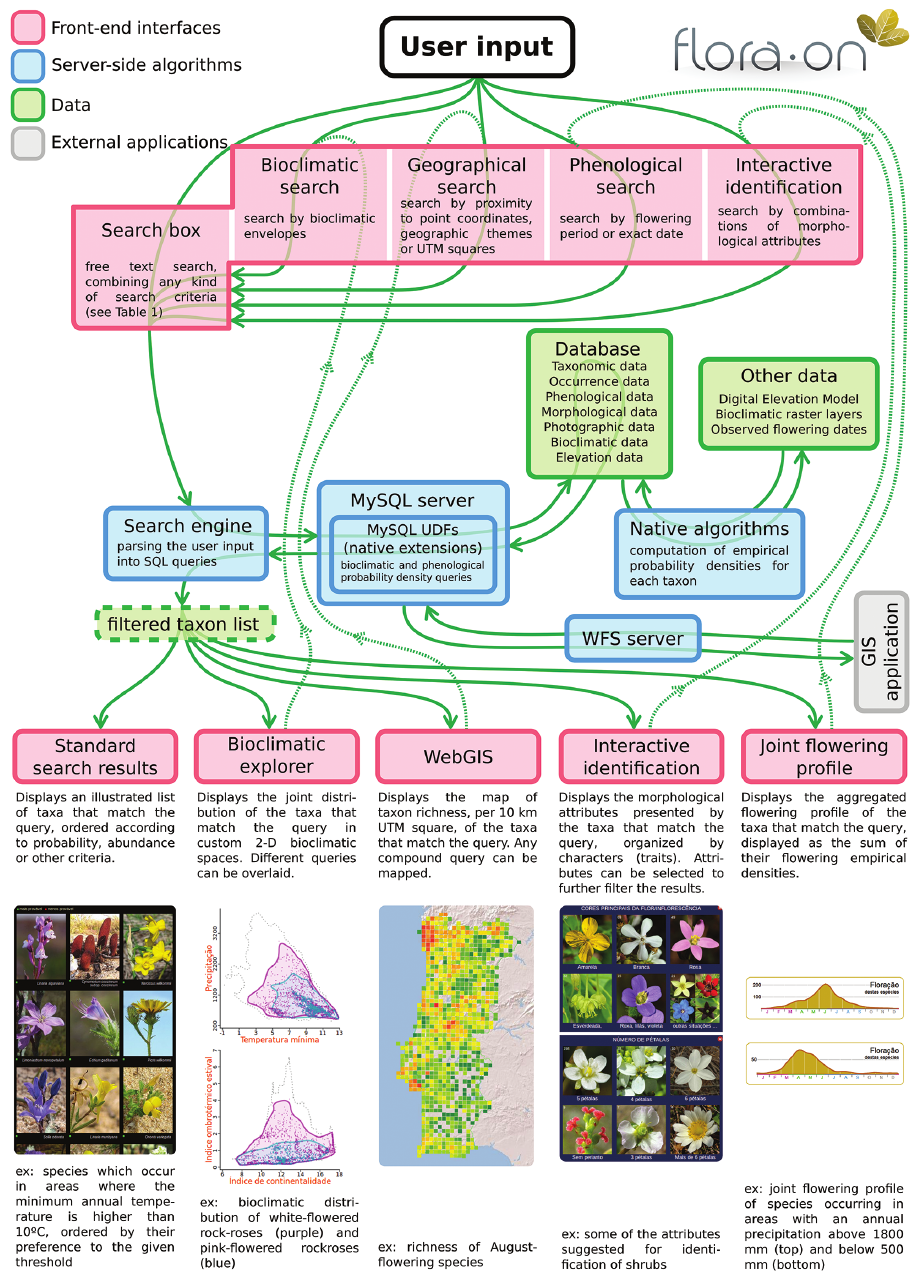
Figure 2. Internal structure, data flow and front-end interfaces of Flora-On. Pink boxes represent the front-end interfaces that interact with the user (input and/or output). Green boxes represent the data, either permanent or temporary (dashed box). Blue boxes represent the internal server-side algorithms that parse the user queries, process and summarise the raw data, and deliver the results to the front-end